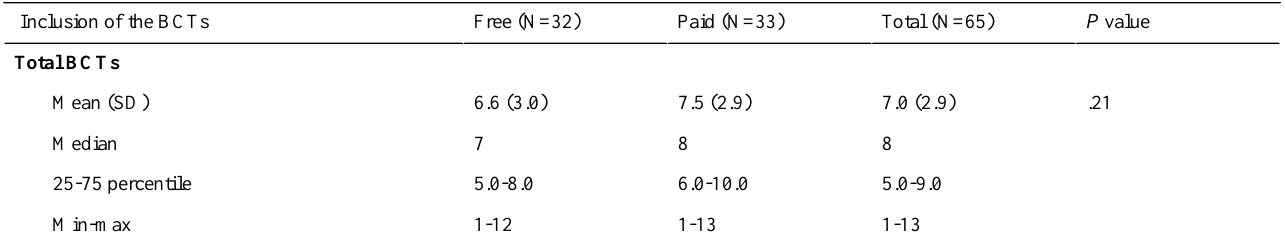
Table 5. Descriptive statistics for the inclusion of the behavior change techniques